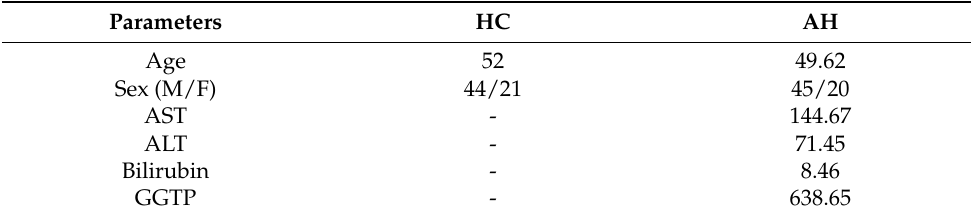
Table 1. Characteristics of the study